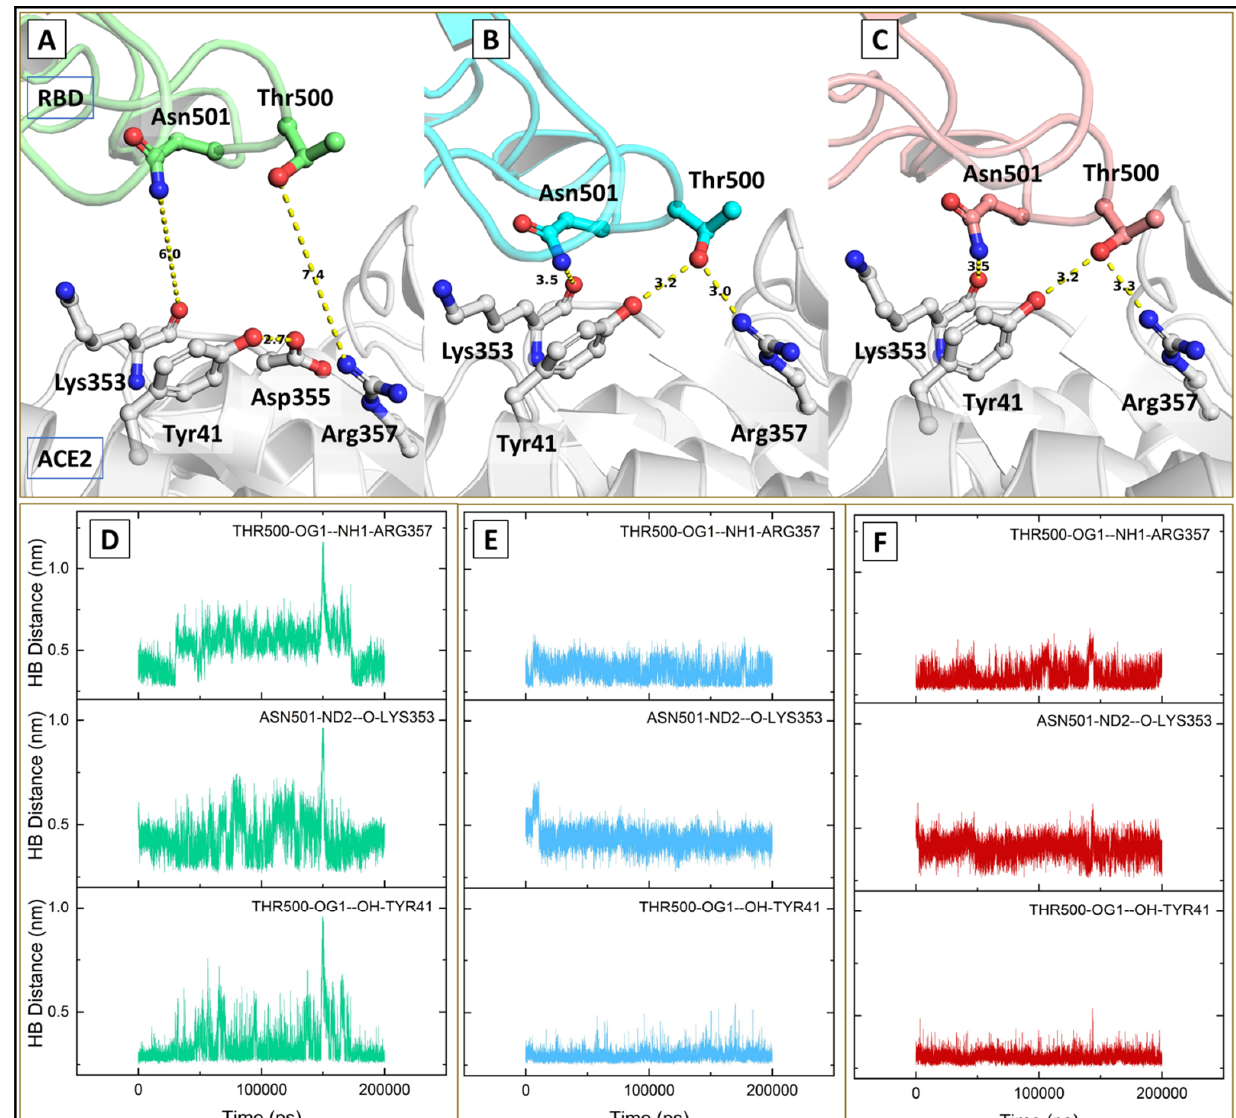
Figure 9. Intermolecular hydrogen bonds at the binding interface ( A – C ) showing hydrogen-bonded interactions in the wild (green), kappa (cyan), and delta (red) respectively; ( D – F ) plot for hydrogen bond distances during simulation time.